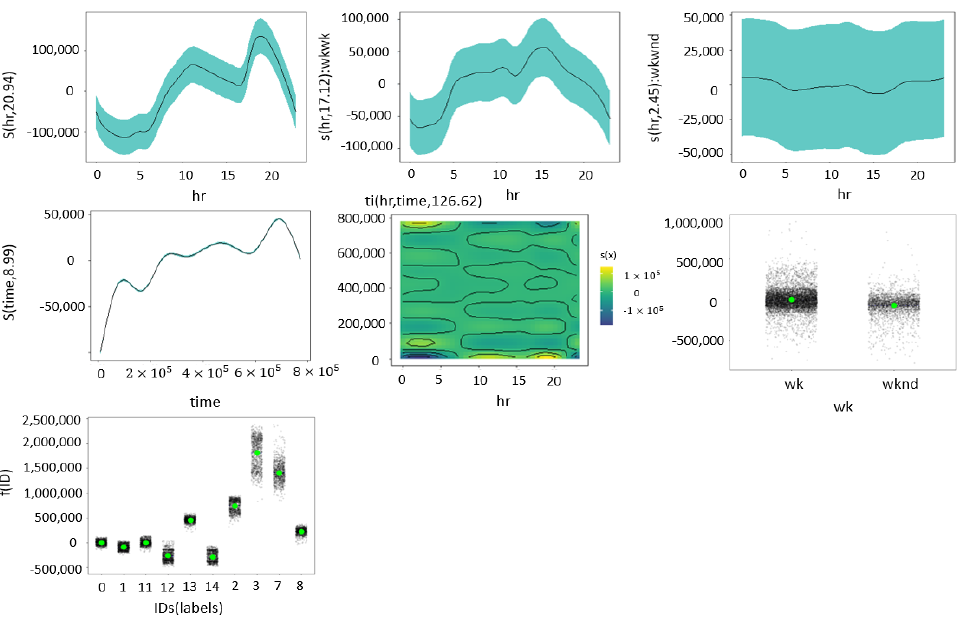
Figure 9. Partial effects for the extended non-spatial GAM with a spatial categorical variable: effects for individual covariates, interaction covariates and parametric factor terms.